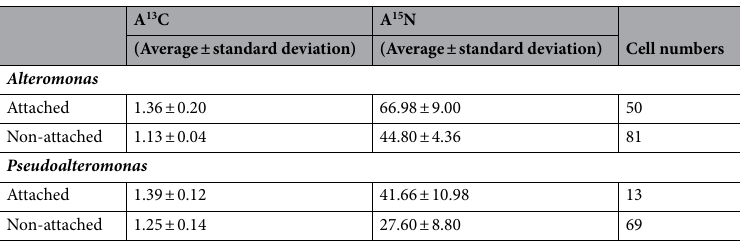
Table 1. Isotopic abundances presented as fractions of identified bacteria (average ± standard deviation) including all time points. Attached bacteria are significantly more isotopically enriched than non-attached ones for both phylogroups and both isotopes (Wilcoxon–Mann–Whitney, p < 0.05).